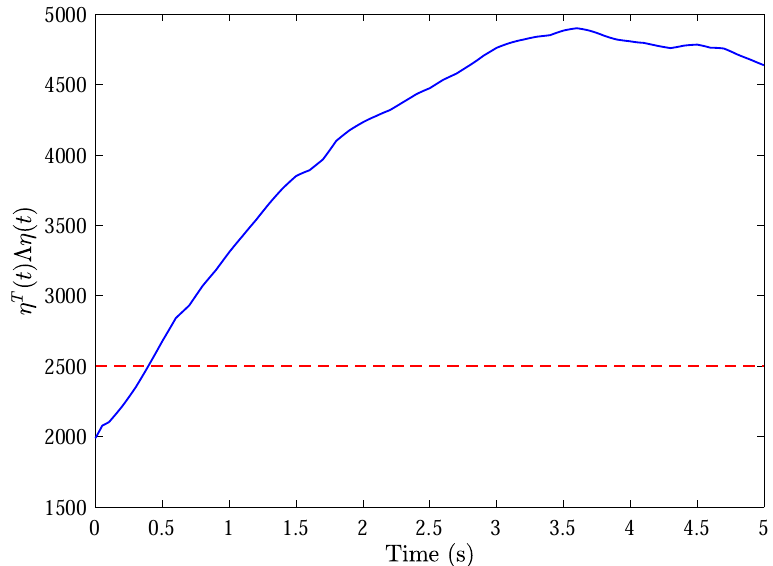
Figure 3. State trajectories of η T ( t ) Λ η ( t ) (bule) with c 1